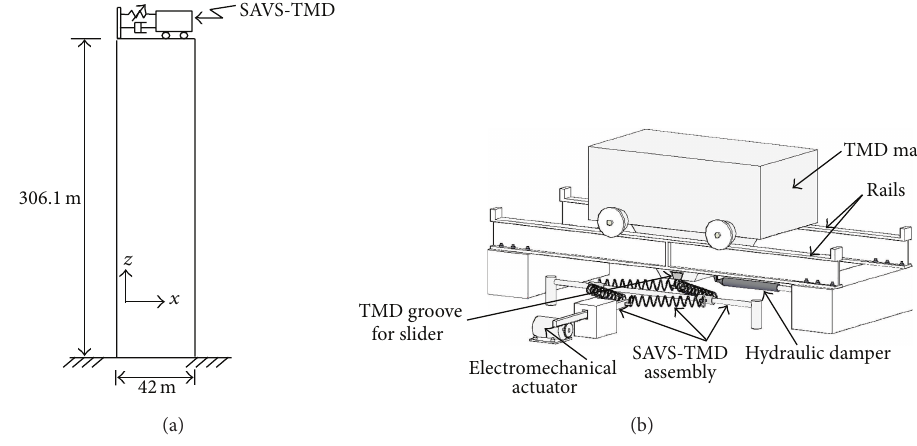
Figure 1: (a) Benchmark building with SAVS-TMD. (b) Realization of SAVS-TMD inspired by